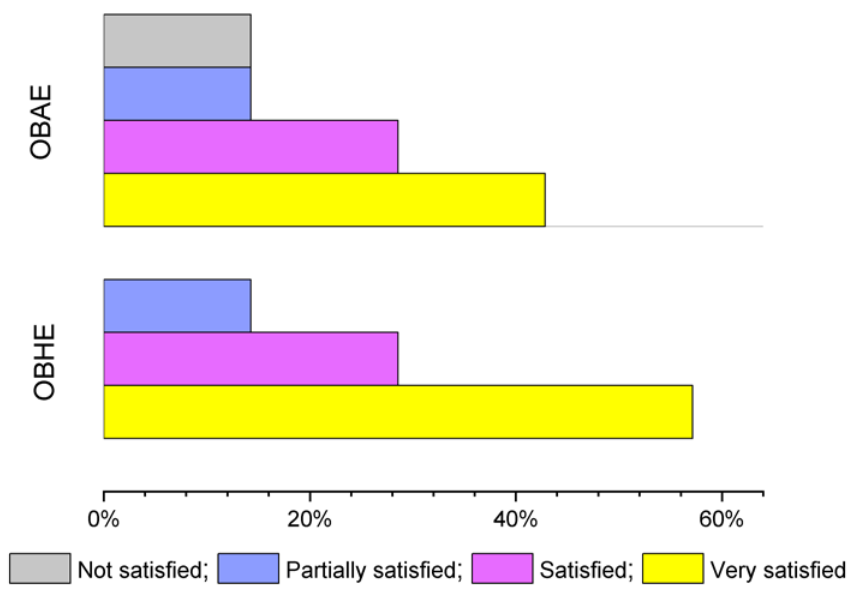
Figure6. Satisfactionscorefortestbasilextracts, basedonleaves(OBHE)andaerialpart(withoutleaves— Figure 6. Satisfaction score for test basil extracts, based on leaves (OBHE) and aerial part (without OBAE), after three days’ leaves—OBAE), after three days’ test.